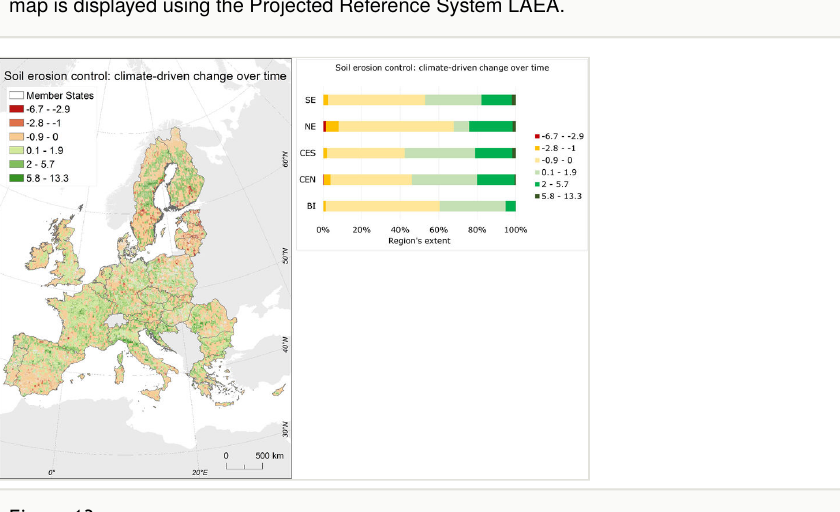
Change in air quality regulation over time (2050 vs. baseline), in areas where LULC was predicted to remain unchanged. Areas mapped in dark red indicate largest percent decrease, areas mapped in dark green indicate the largest percent increase. The bar chart shows the change as a relative extent percent, for fi ve European regions de fi ned after grouping the 28 Member States according to their climatic characteristics (Ciscar Martinez et al. 2011). The map is displayed using the Projected Reference System LAEA.